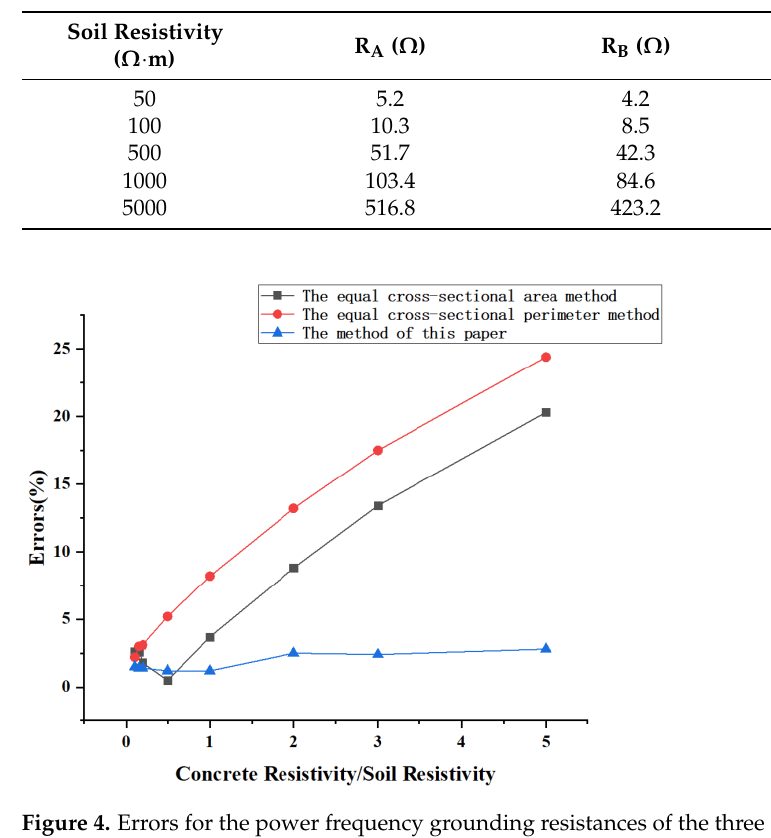
Table 5. Power frequency grounding resistances under different soil resistivities in the equal cross- sectional perimeter method.